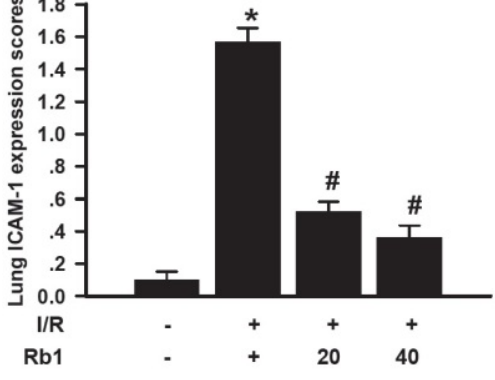
Figure 8. Effects of Rb1 on ICAM-1 expression of lung tissue after intestinal I/R